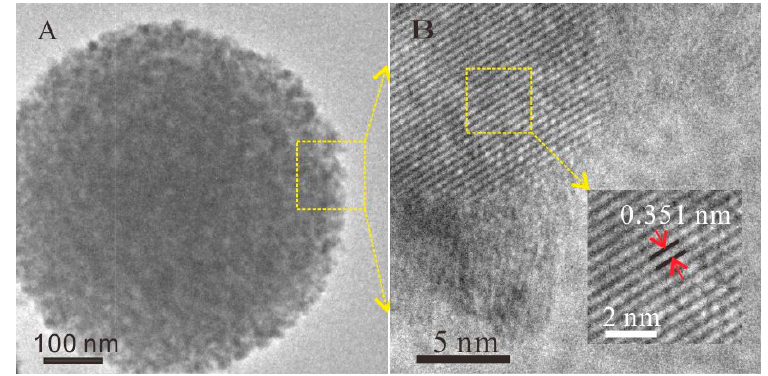
Figure 1. ( A ) TEM image of the TiO 2 particle; ( B ) enlarged HRTEM image of details of the TiO 2